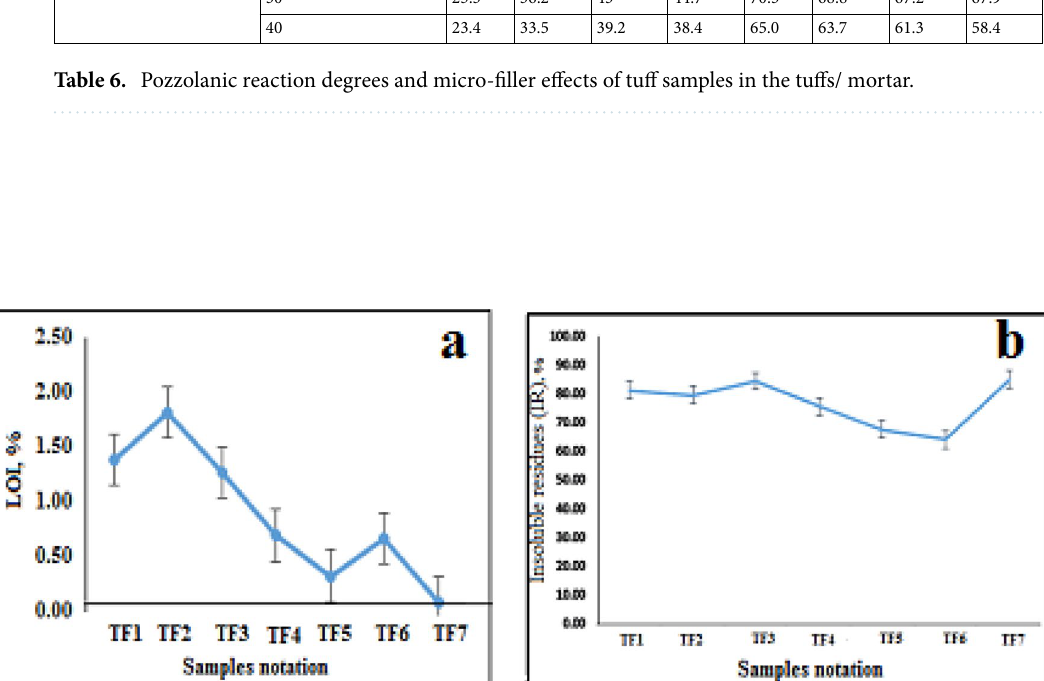
Figure 4. Loss on ignition (L.O.I.) in tuffs samples ( a ), and Insoluble residues (IR) values of tuffs samples ( b